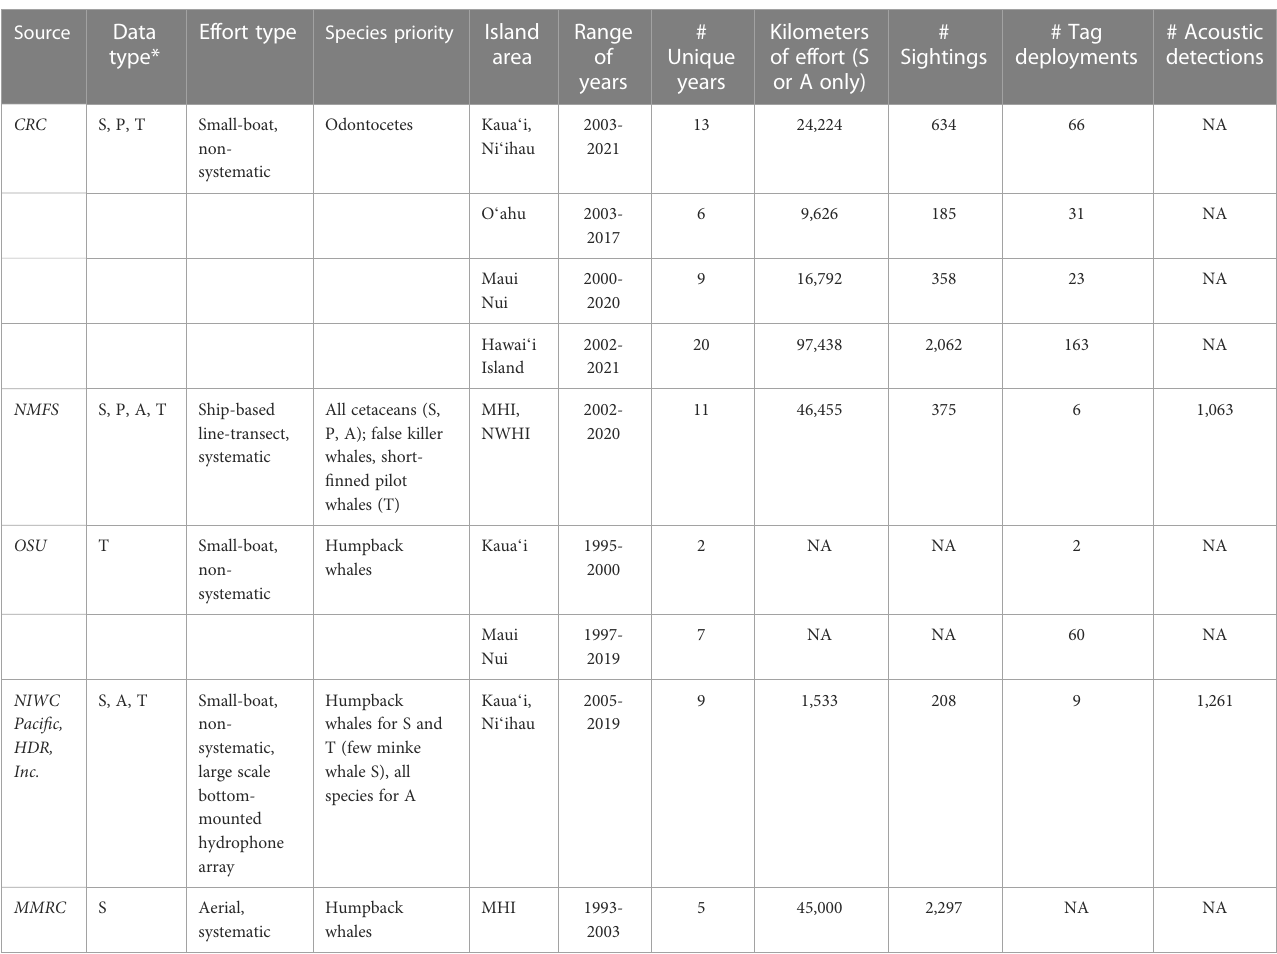
TABLE 1 Summary of data sources incorporated in the Hawai ʻ i BIA regional